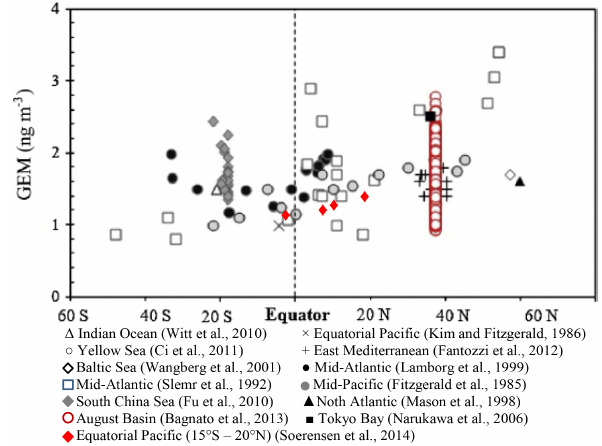
Figure 3. Compiled values for several marine/oceanic environmen- tal systems. (Based on the figure from Bagnato et al., 2013.)